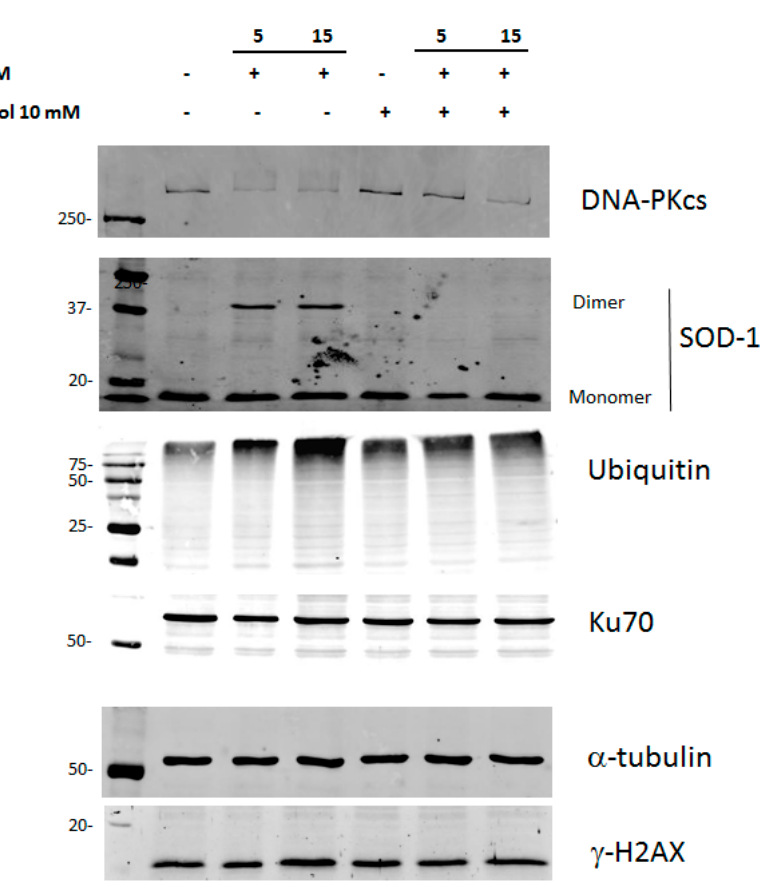
Figure 6. Pre-incubation with thioglycerol restores the level of DNA-PKcs by preventing dimerization of SOD1 in cancer cells exposed to NSC. PC-3 cells were pre-incubated with 10 mM thioglycerol for 15 min then incubated with 100 µM NSC for 5 or 10 min. Proteins were analyzed by Western blotting with the corresponding antibodies to detect DNA-PKcs, anti-SOD-1, ubiquitinated targets and γ H2AX. Ku70 was used as a negative control (see above) and α -tubulin as a loading control.